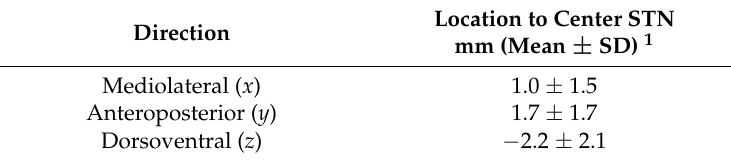
Table 2. The three-dimensional active contact locations after one